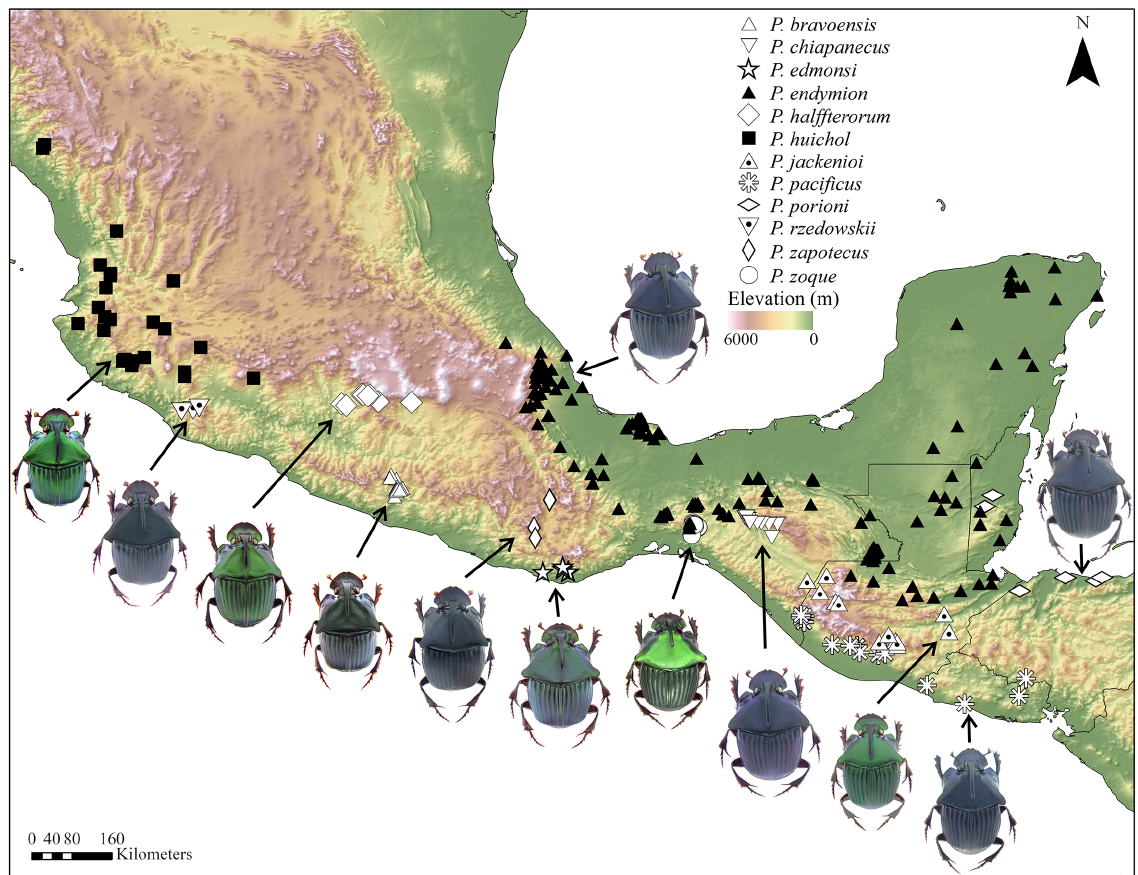
Fig. 15. Distribution of the Phanaeus endymion species group in North and Central America (in